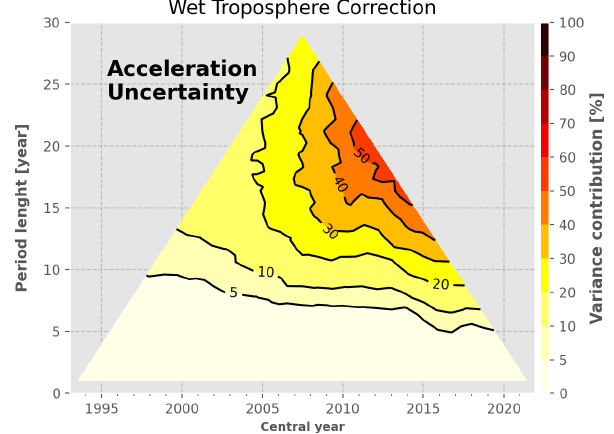
Figure B6. Variance contribution to the GMSL acceleration vari- ance of TP data